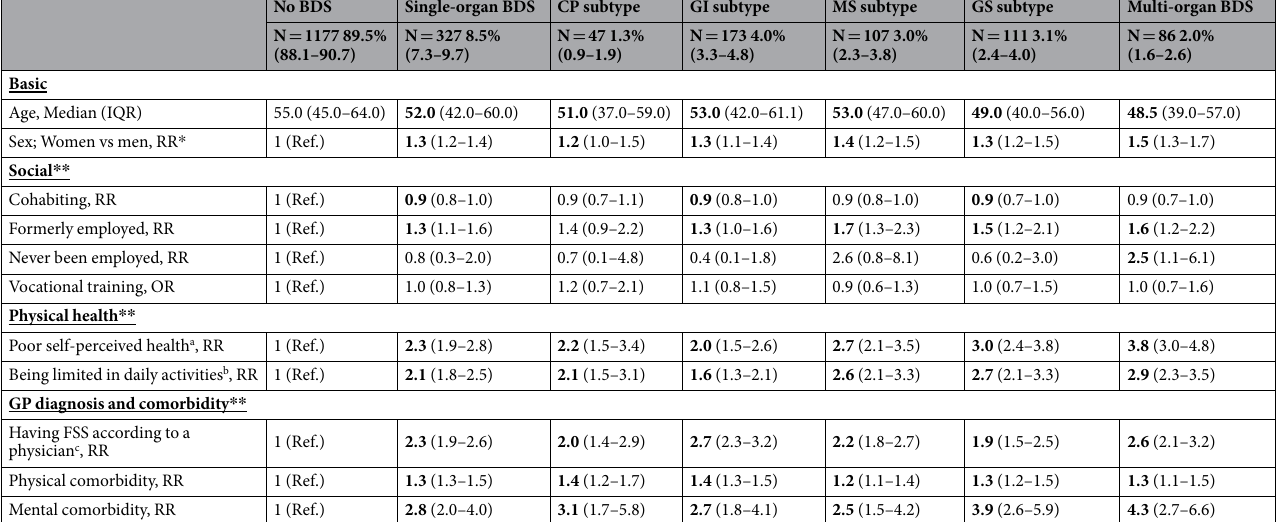
Table 2. Prevalence and characteristics of participants with and without bodily distress syndrome. Abbreviations: BDS = bodily distress syndrome; CP = cardiopulmonary; GI = gastrointestinal; MS = musculoskeletal; GS = general symptoms type. IQR = interquartile range; RR = relative risk; OR = odds ratio. * Adjusted for age. ** Adjusted for age and sex. a Fair or poor health 89 . b All of/most of/some of the time 89 . c